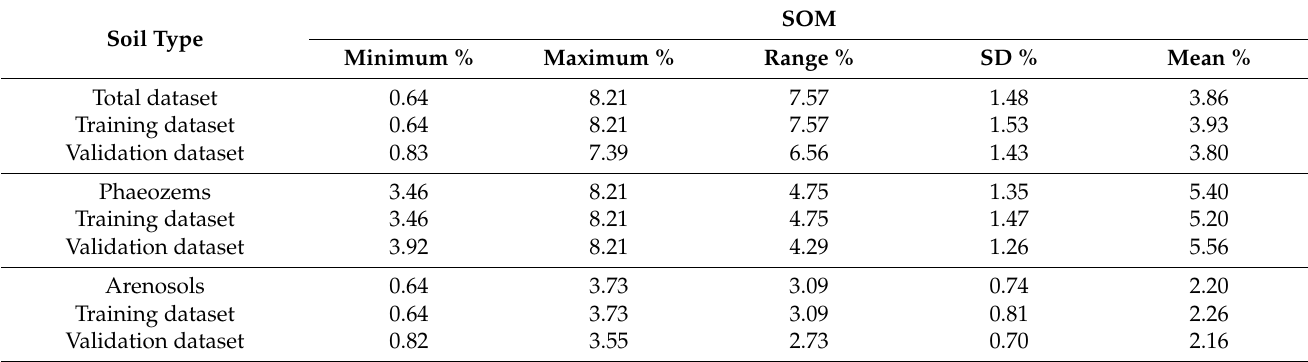
Table 3. Descriptive statistics on the SOM contents for the total, Phaeozem, and Arenosol datasets and their training and validation sample